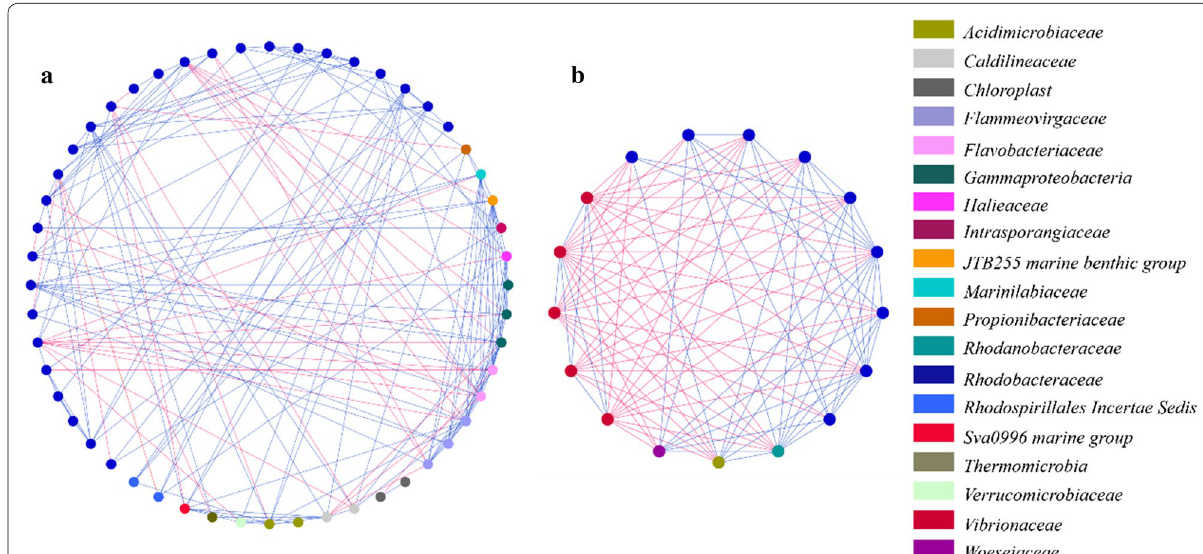
Fig. 5 Network analysis revealing co-occurrence patterns of healthy ( a ) and diseased ( b ) core microbiota. Each node represents a bacterial OTU. The colors of the nodes indicate the OTUs affiliated to distinct major families. A blue edge indicates a positive correlation, whereas a red edge indicates a negative correlation between